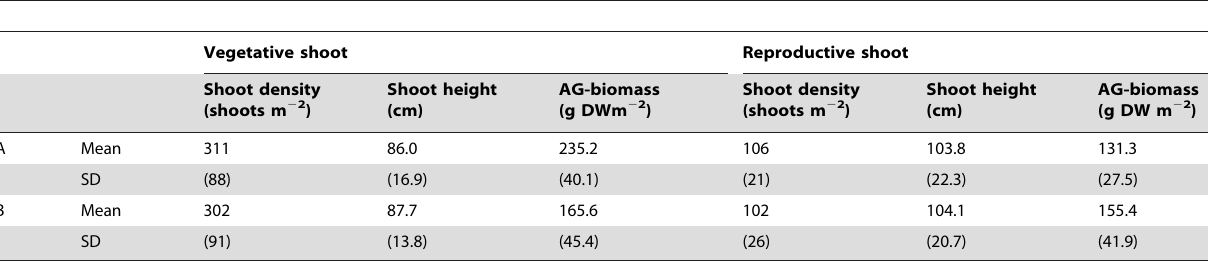
Table 2. Shoot density, shoot height, and aboveground biomass (AG-biomass) for a natural intertidal Zostera marina bed (Qingdao Bay) monitored on June 21, 2009 (A) and June19, 2012 (B). Values are means ( 6 SD).